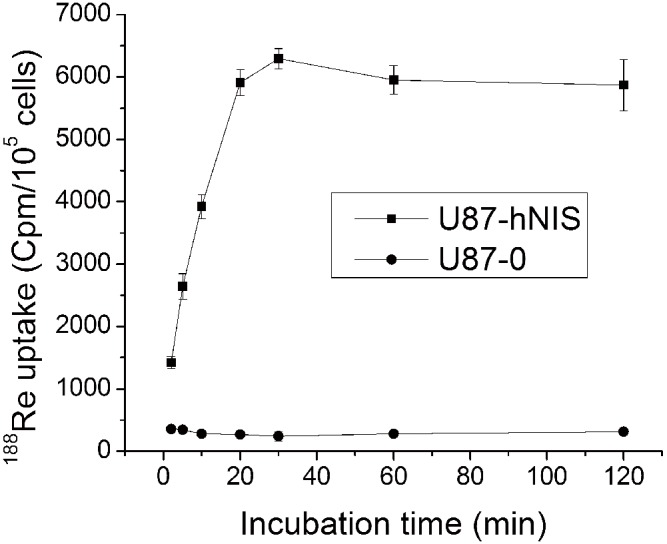
Time dependent 188Re uptake by U87-hNIS cells.
188Re uptake was measured by incubation for various time periods with 3.7 kBq of 188Re in bHBSS. Results are expressed in numbers of counts per minute for 105 cells. The upper line represents U87-hNIS cells, while the lower line represents U87-0 cells. Data points are means ± SD (n = 3).